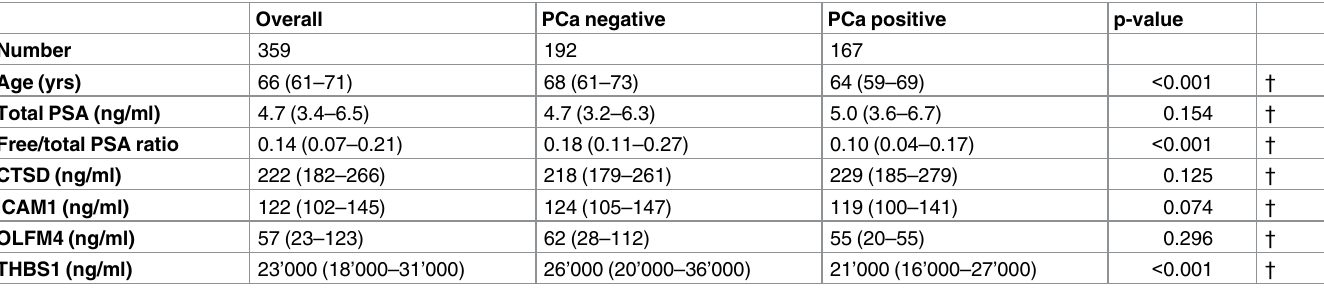
Table 2. Patient characteristics